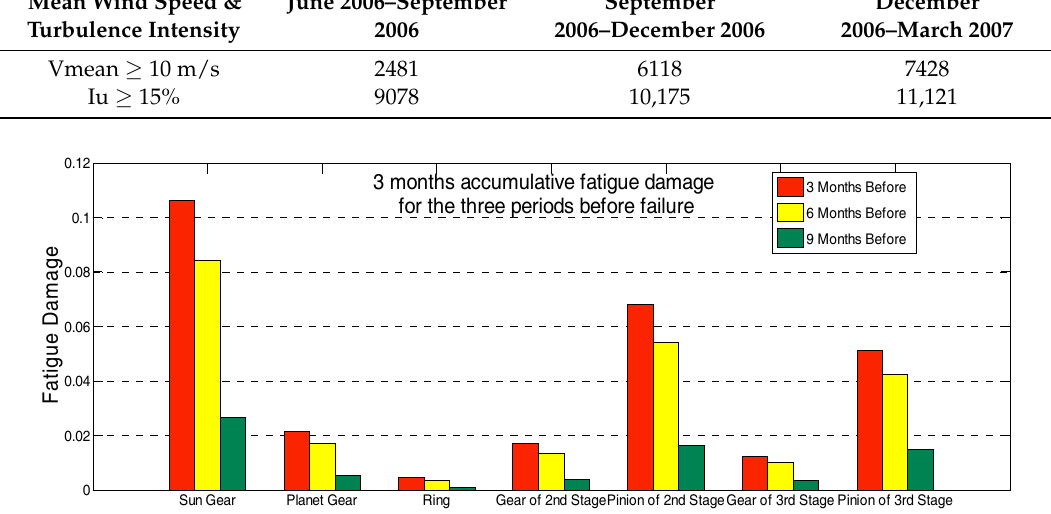
Figure 18. The accumulative fatigue damage of three months at different periods.